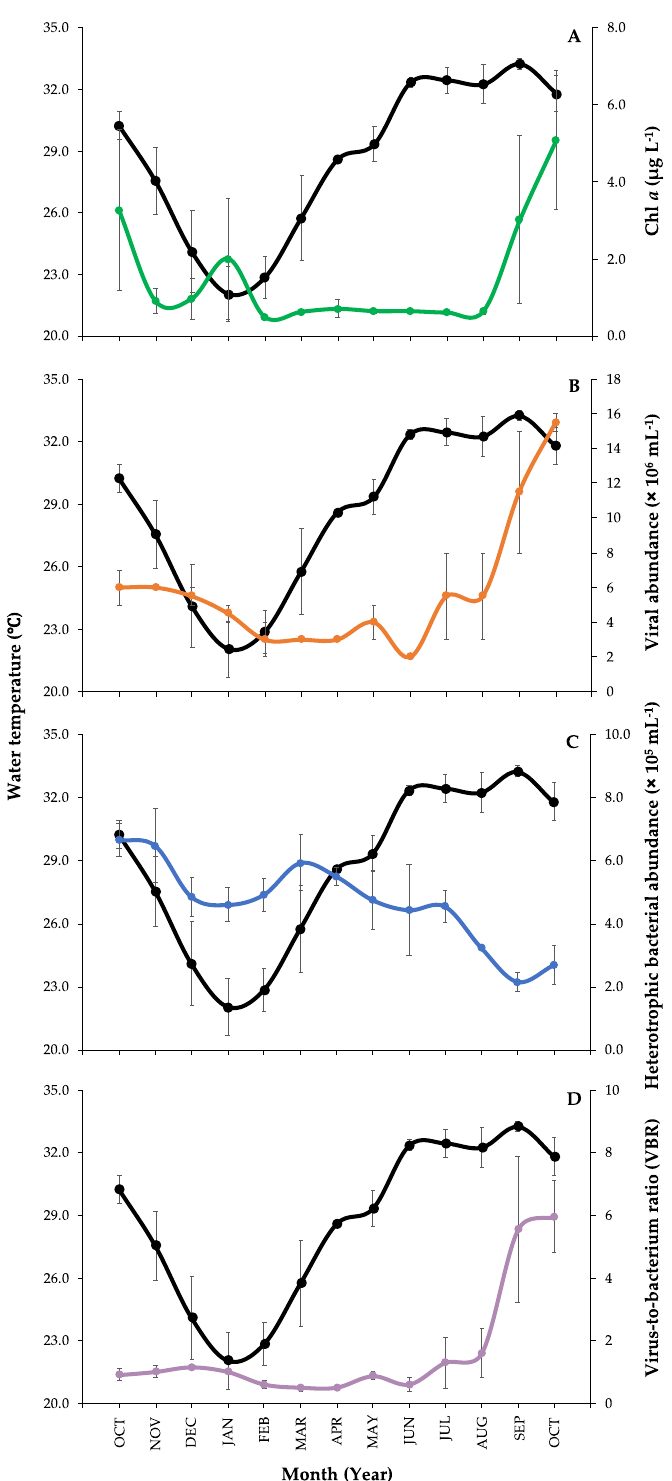
Figure 2. Temporal variability (monthly average ± SE) on different environmental parameters studied during the time series sampling in the coastal lagoon in the Red Sea (2017 to 2018). ( A ) Chl a concentration (green line and dots), ( B ) Viral abundance (orange line and dots), ( C ) Heterotrophic bacterial abundance (blue line and dots), and ( D ) Virus-to-bacterium ratio (VBR) (purple line and dots). The black line in all the plots corresponds to the surface water temperature of the Red Sea coastal lagoon area.